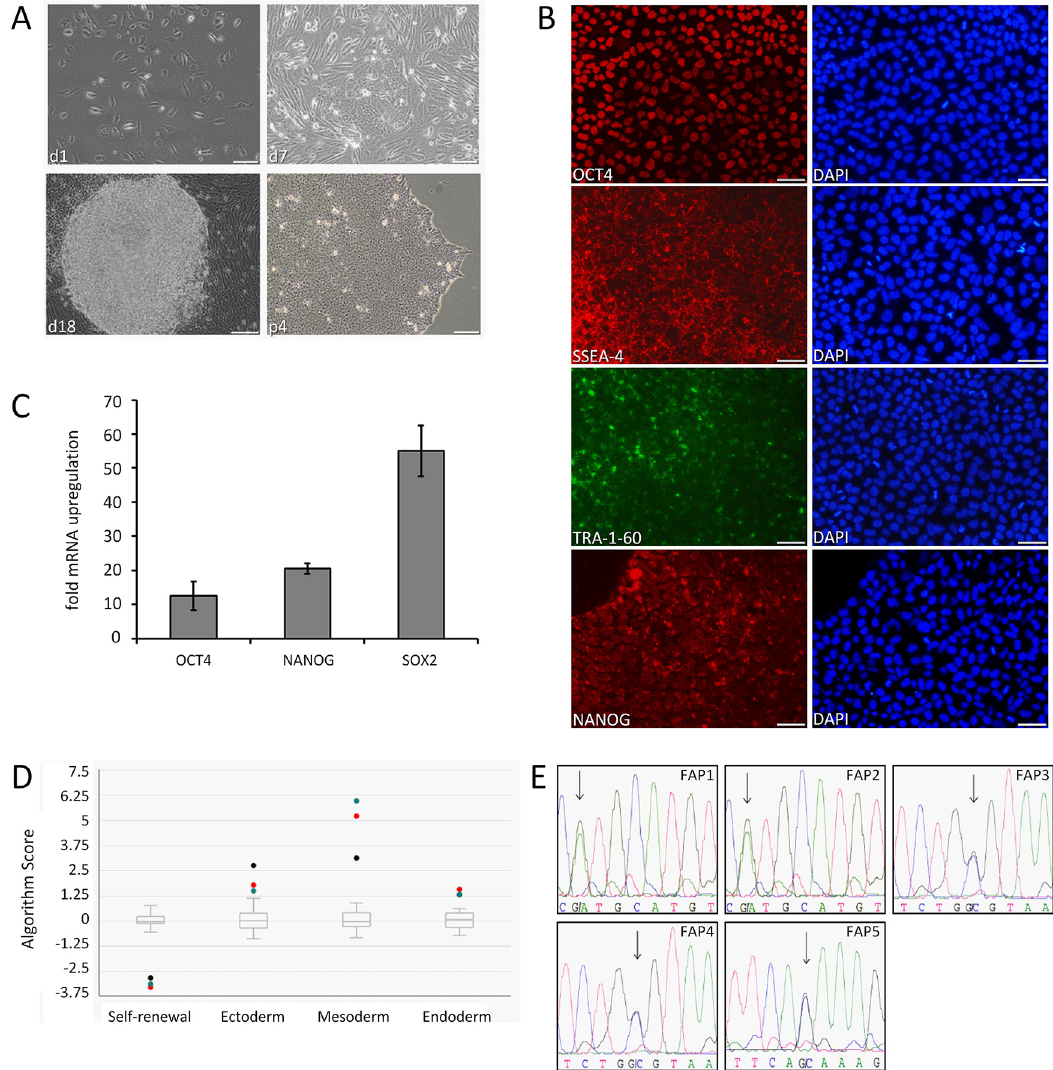
Fig 2. Reprogramming of urine cells obtained from FAP patients. (A) Typical brightfield images of UCs from a FAP patient at different times after reprogramming. FAP2 derived cells are shown. Scale bars, 100 μ M. (B) Immunofluorescence stainings of cells after reprogramming. DAPI was used for nuclear counterstaining. FAP5 derived cells are shown as one typical example. Scale bars, 50 μ M. (C) Gene expression analysis of reprogrammed cells. Relative expression to housekeeping gene is shown. Mean ± SE of FAP1 to FAP5 are shown. (D) EB expression profile of pluripotency- and lineage-specific markers derived from FAP iPSCs. Dots indicate sample scores of cells derived from patients FAP1 (black), FAP2 (red) and FAP4 (green). Human embryonic stem (hES) and iPS cell lines served as control (box plot). (E) DNA sequencing chromatograms of the TTR gene derived from FAP iPSCs. Heterozygotic variant nucleotides are shown by